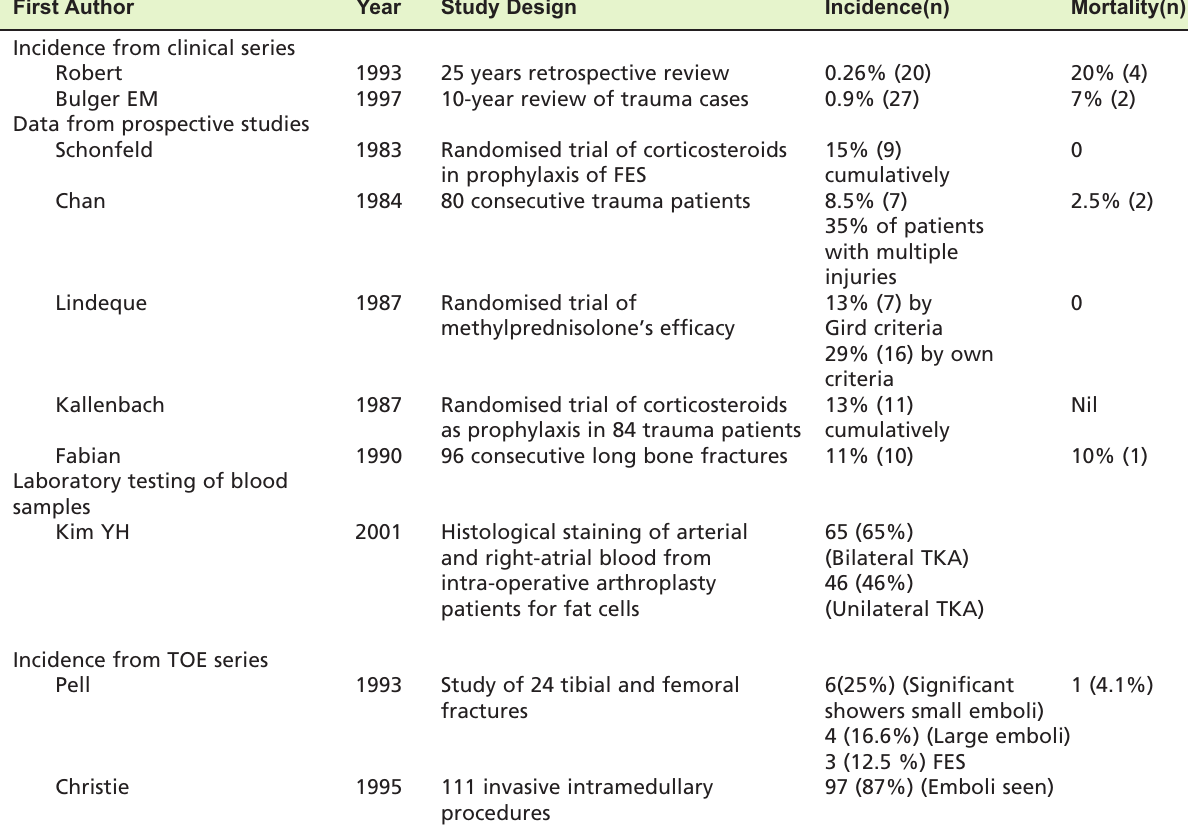
The incidence and mortality of fat embolism syndrome in recent and landmark series Table I: